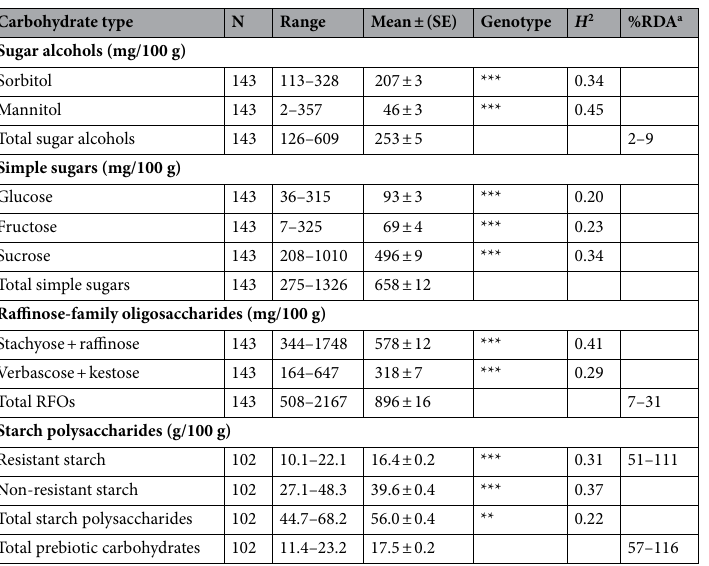
Table 2. Carbohydrate analysis with the number of accessions (N), range, overall mean with standard error (SE), and heritability estimates ( H 2 ). a %RDA is based on a recommended daily allowance of 7 g/day for sugar alcohol 40 , 7 g/day for raffinose-family oligosaccharides 41 , and 20 g/day for resistant starch and total prebiotic carbohydrates 42 . A genotype is noted as significant at ** P < 0.05 and *** P < 0.01. H 2 broad-sense heritability estimate. Total prebiotic carbohydrates include resistant starch, raffinose-family oligosaccharides, and sugar alcohols. N: number of